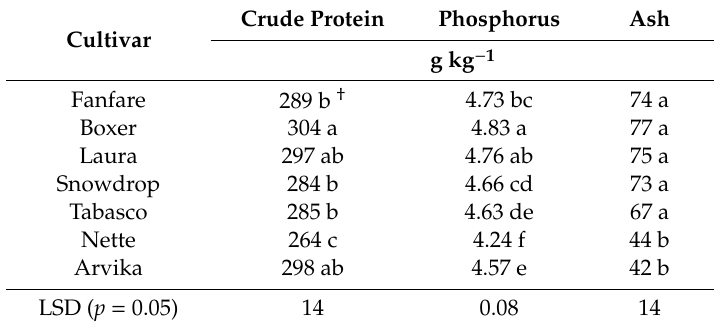
Table 7. Cover crop crude protein, p and content averaged across four environments at Hickson and Prosper, ND, USA, in 2017 and